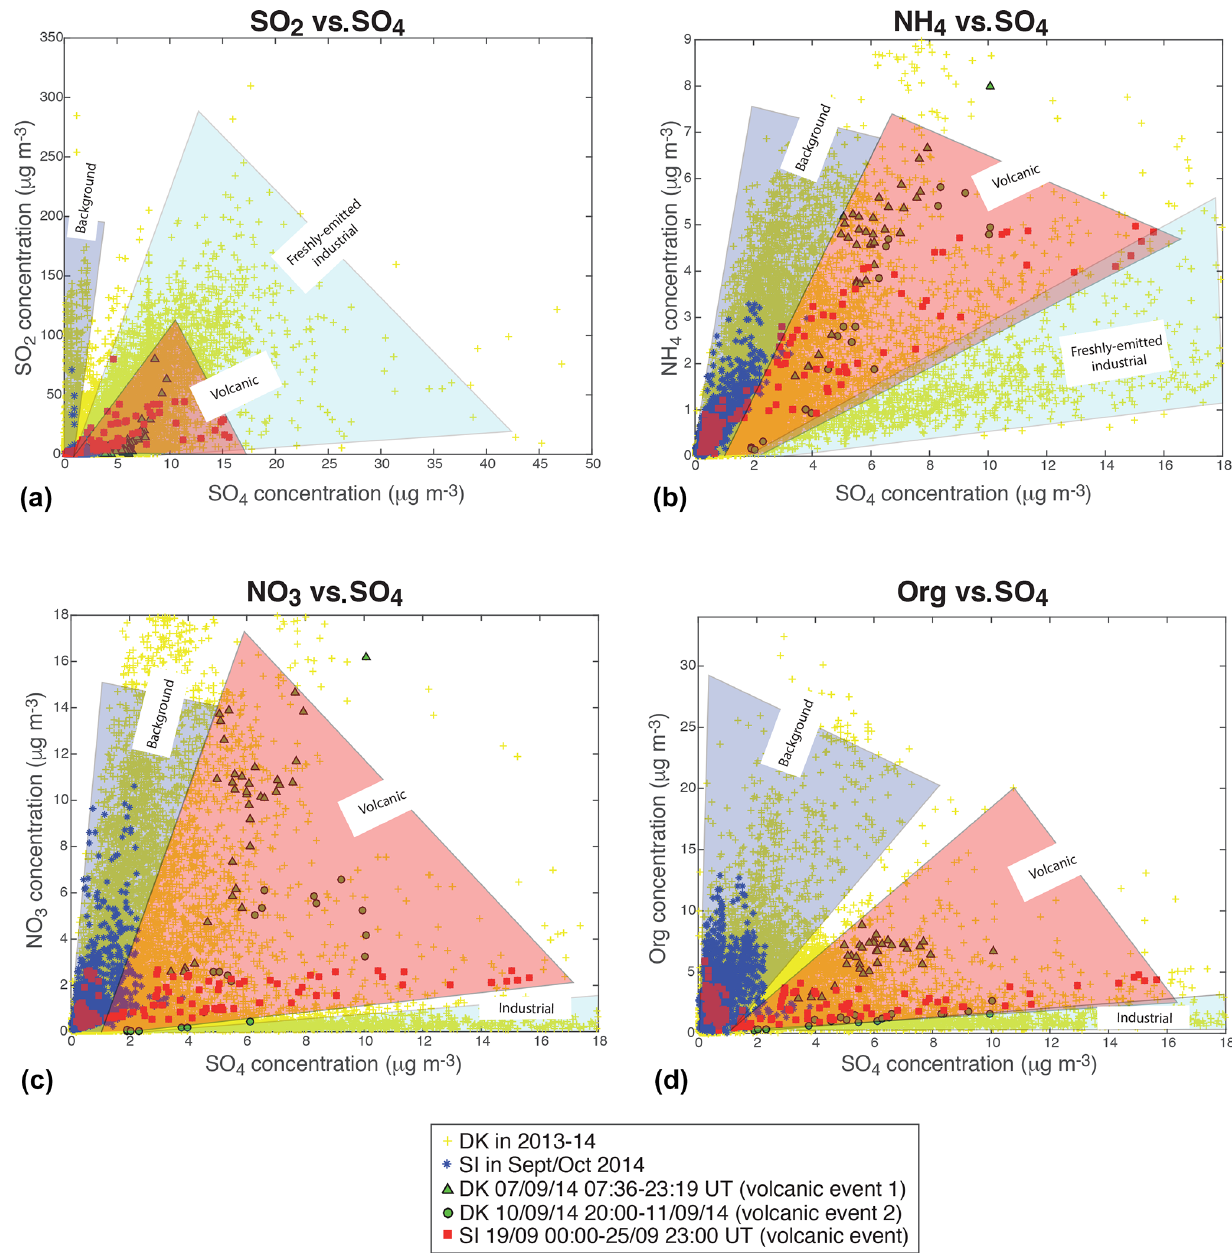
Figure 8. Distinction of aerosol sources, either representative of background conditions at SIRTA (blue) or of volcanic (red) or industrial (cyan) origins, in the scatter plots of (a) gaseous SO 2 from air quality stations, and various ACSM particulate species: (b) NH 4 , (c) NO 3 and (d) Org, vs. sulfate mass concentrations. Sectors in colour, added to facilitate interpretation, represent an envelope roughly spanning the range of observed gas and particulate mass concentration values according to the type of